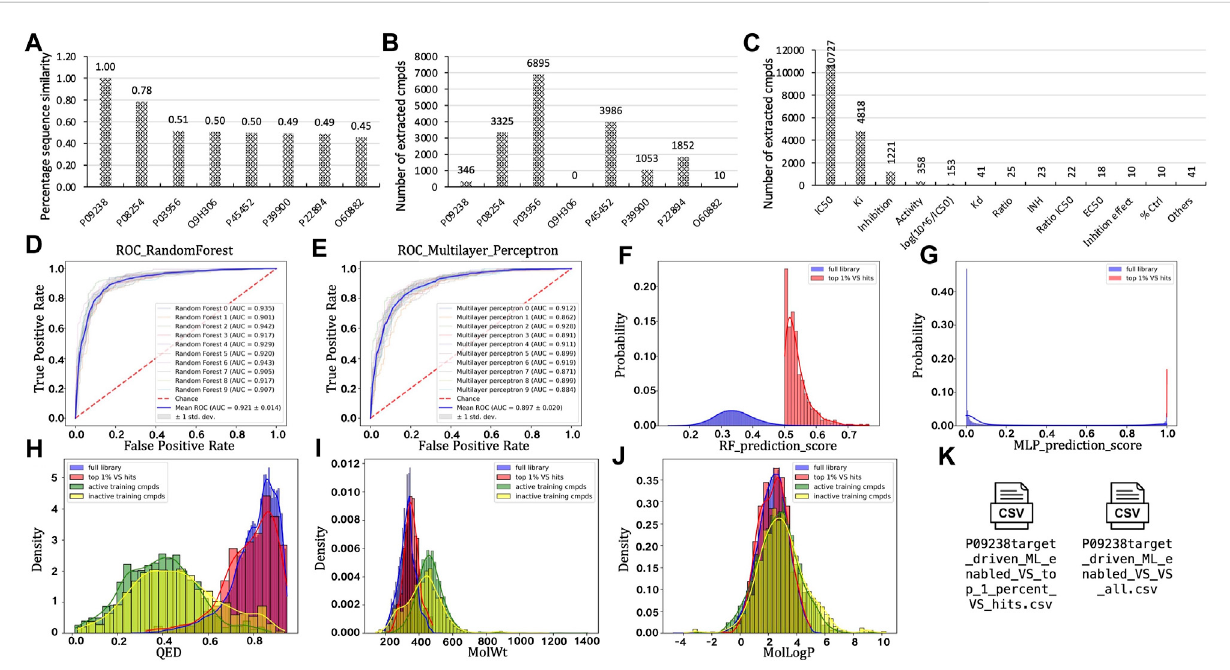
FIGURE 2 Applying target-driven, ML-enabled VS toward stromelysin-2 (UniProt ID: P09238) as a case study to exemplify outcomes from each module. (A) . Proteinlistaftertargetexpansion. (B) .Numberofextractedcompoundsforeachtargetintheproteinlist. (C) .Distributionofexperimentalvaluetypes. (D) . ROC curve for RF model training. (E) . ROC curve for MLP model training. (F) . Distribution of prediction scores on the Enamine Diversity 50K library using theRFmodel. (G) .DistributionofpredictionscoresontheEnamineDiversity50KlibraryusingtheMLPmodel. (H) .DistributionofcalculatedQED. (I) . Distribution of calculated MW. (J) . Distribution of calculated LogP. (K) . Exempli fi ed fi nal reports.